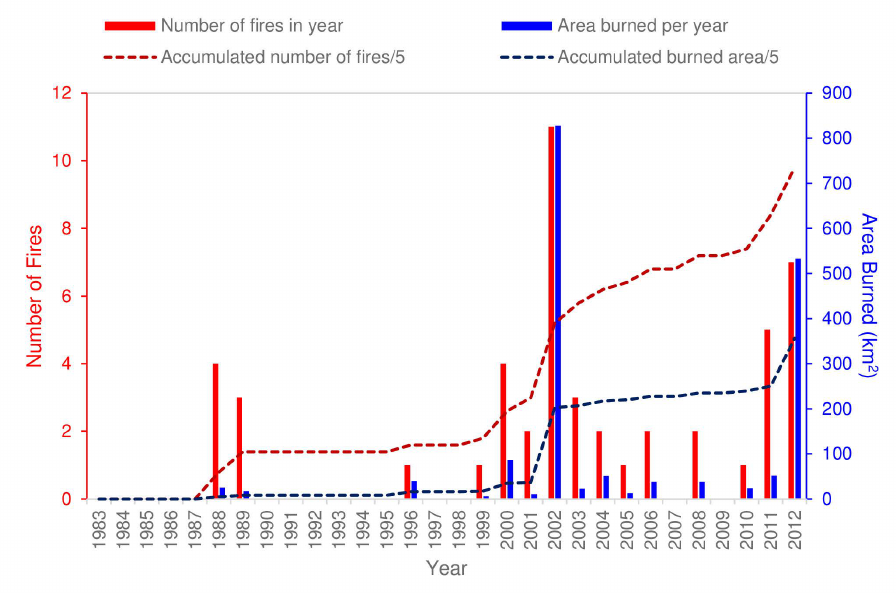
Figure A1. Number of fires in red and burned area per year in blue for the region of interest in the period 1983–2012. The dotted lines represent the accumulated number of fires and burned area scaled by a factor of 0.5 to facilitate visualization